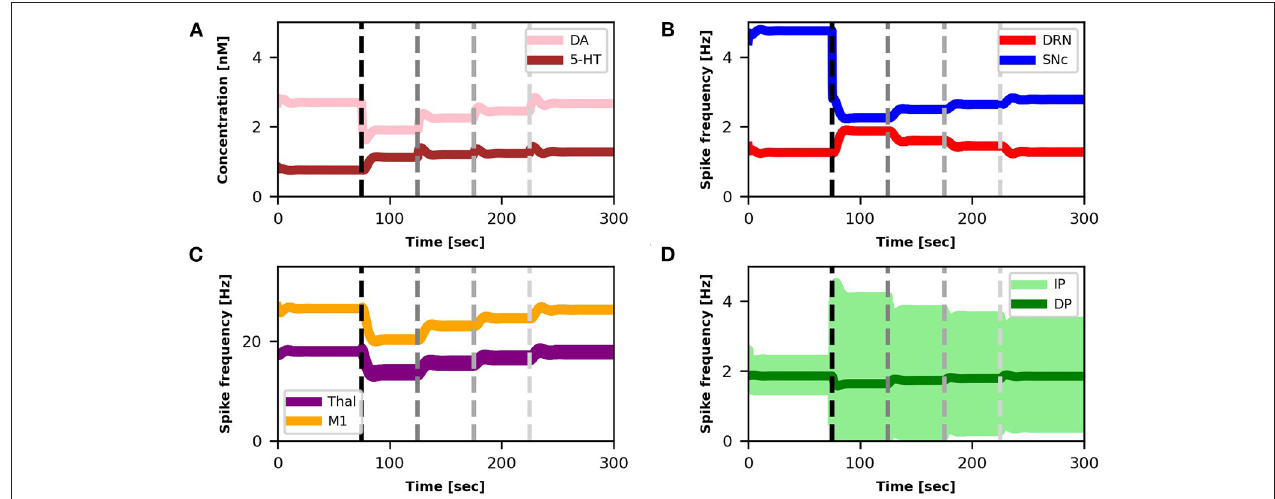
FIGURE 6 | Relationship between activities of model components and changes in DA and 5-HT concentrations after SNc damage and selective serotonin inhibitors (SSRIs) simulated treatment. The first dotted vertical line (black) represents the timing of the lesion in the dopaminergic circuits ( τ SNc + 70 % , α IP + 333 % ). The other three dotted vertical lines (gray scale) indicate the beginning of different serotonin-based drug (SSRIs) treatment periods with different doses of the treatment ( τ